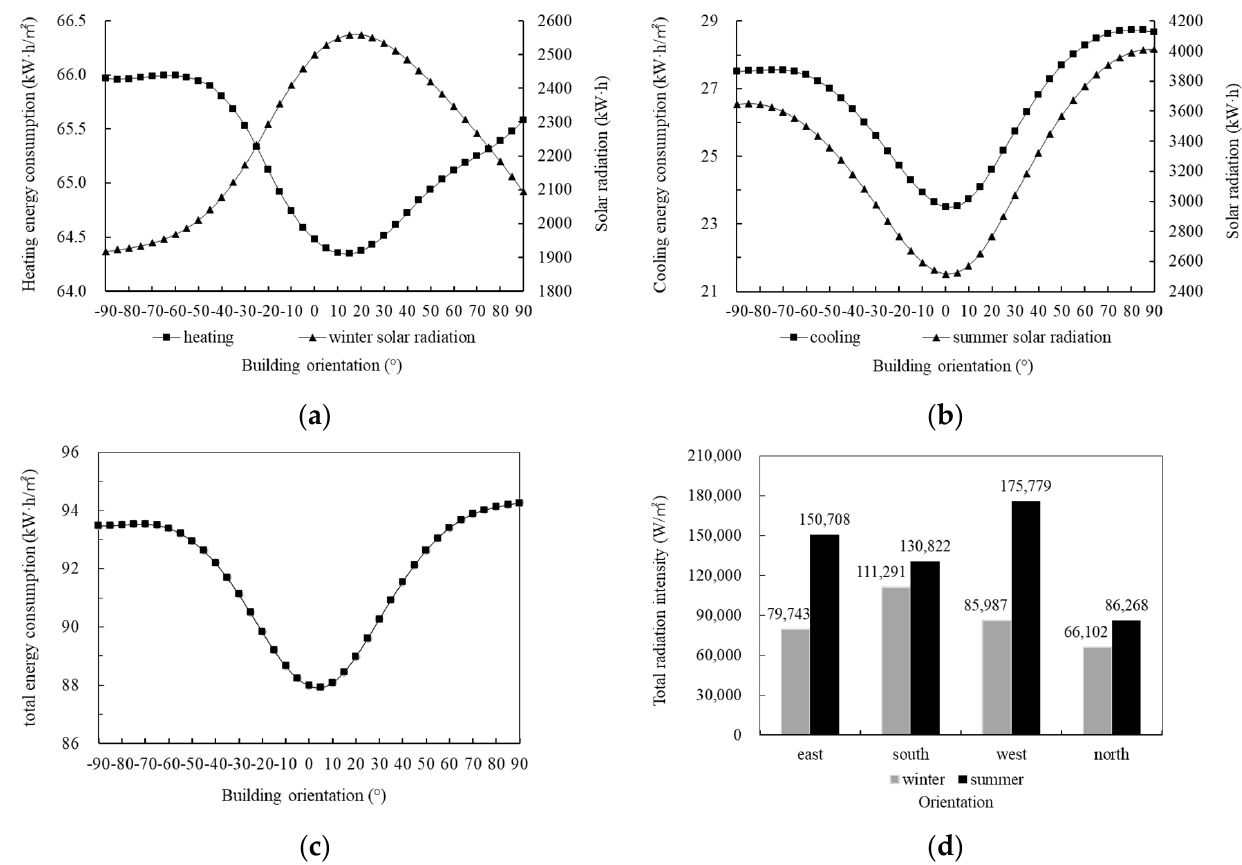
Figure 6. Relationships between building orientation and energy consumption and total radiation intensity: ( a ) heating energy consumption; ( b ) cooling energy consumption; ( c ) total energy consumption; ( d ) total radiation intensity.